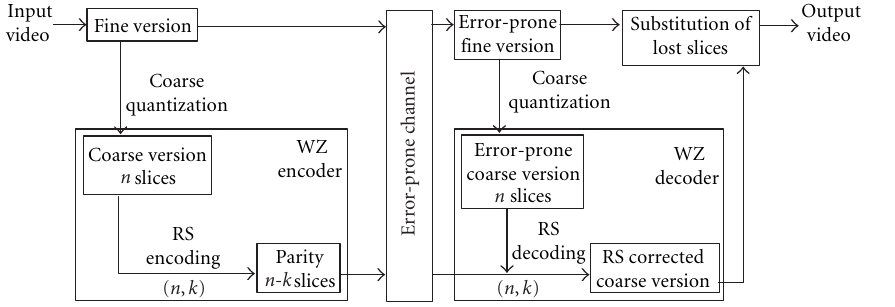
Figure 1: Block diagram of the SLEP scheme proposed in [4].